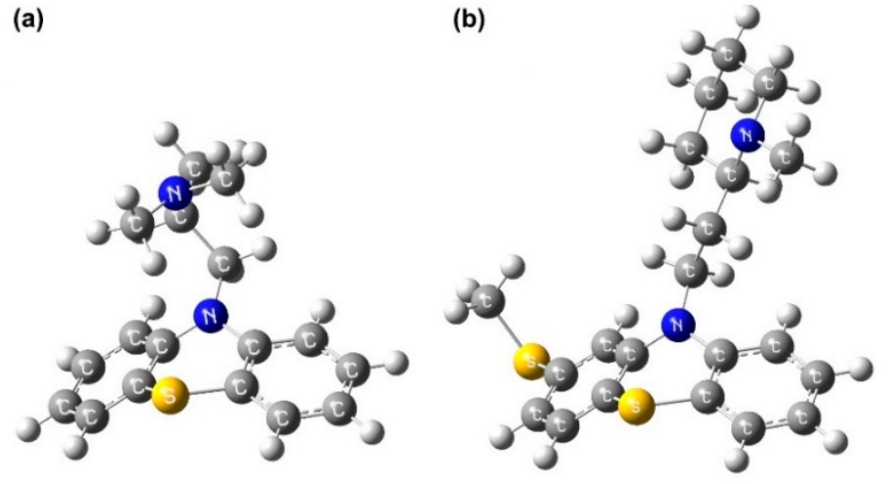
Figure 1. Molecular representation of phenothiazines. Optimized geometry of ( a ) PMZ and ( b ) TZ obtained using Gaussian 09 software (density functional theory with the B3LYP functional and the 6-31G(d,p) basis set) [33].